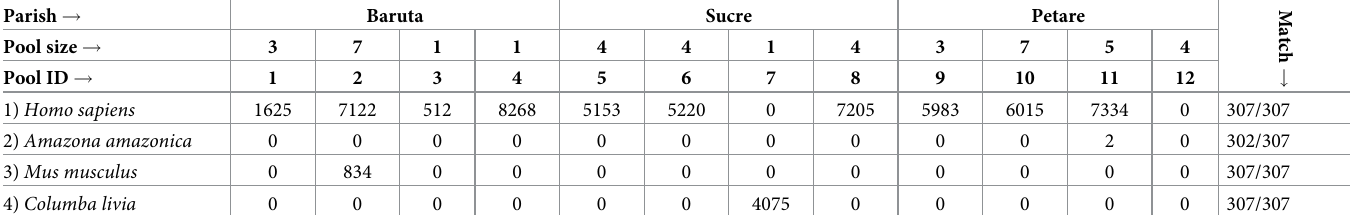
Table 2. Vertebrate sources of cytb DNA identified in P . geniculatus bloodmeals for the MDC collection period 2009–2012. Dissection pools 1–12 are organized in columns based on the parish from which contributing samples were obtained. Pool sizes (i.e., the number of samples contributing to each pool) range from 1–7. Vertebrate species with cytb sequences matching pool sequences at � 90% similarity are listed in rows numbered 1–4. Corresponding read support values are provided at right prior to the ‘Match’ column indicating the fraction of nucleotides matching between pool sequences and the reference (excluding primer binding sites). Parish !